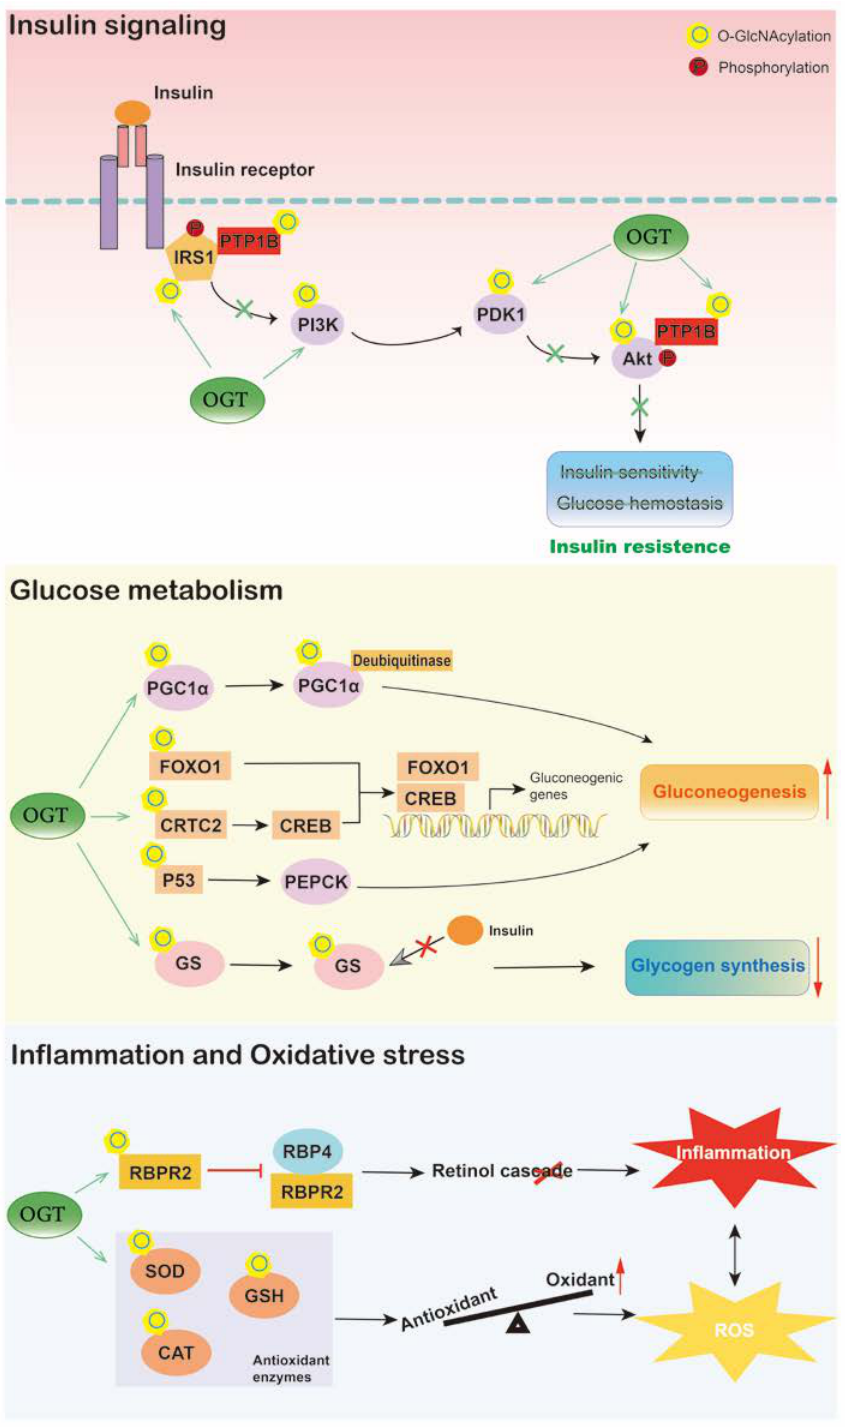
Figure 3. Hepatic O-GlcNAcylation plays an important role in diabetes. O-GlcNAcylation of pro- teins involved in insulin signaling contributes to liver insulin resistance. O-GlcNAc signaling also influences hepatic glucose metabolism, increased O-GlcNAcylation induces gluconeogenesis and inhibits glycogen synthesis, thus exaggerating hyperglycemia. Moreover, under high-glucose sit- uation, O-GlcNAcylation promotes liver inflammation and oxidative stress by triggering retinol cascade disruption and inhibiting antioxidant activities, respectively, which contributes to diabetes development. O, O-GlcNAcylation; P, phosphorylation.